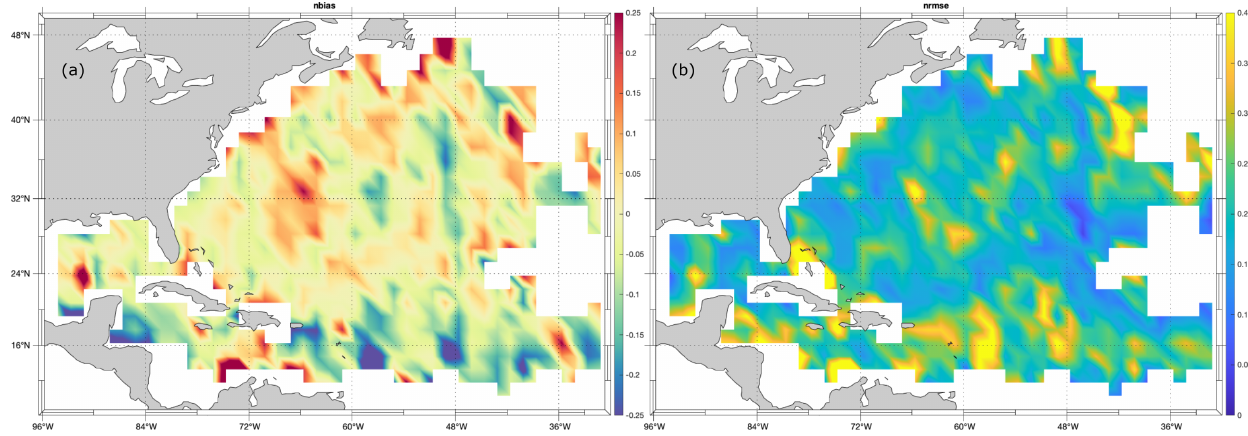
Figure 9. As in Figure 8a for relative ( a ) bias and ( b )